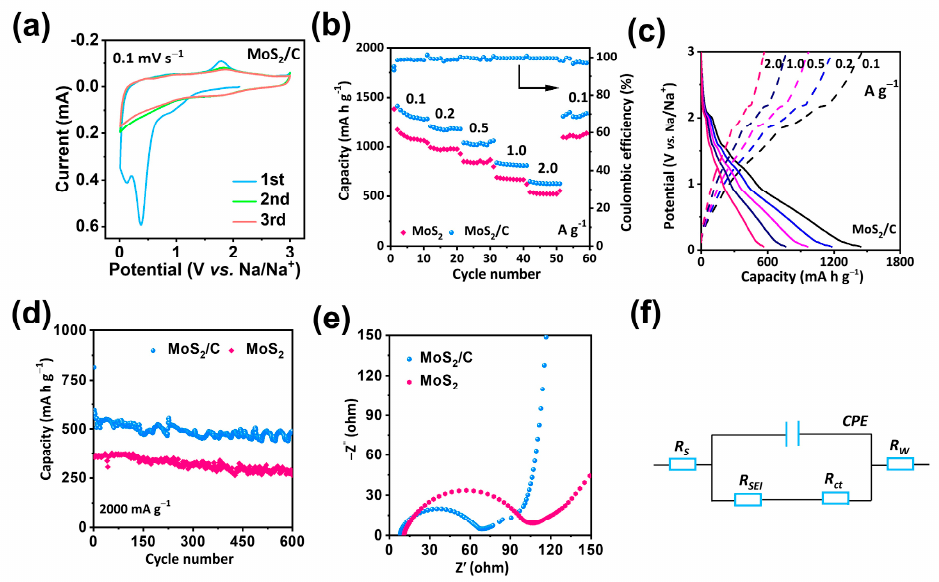
Figure 4. Sodium-ion storage performance. ( a ) CV curves of MoS 2 /C at scan rate of 0.1 mV s − 1 . ( b ) Rate performances at various current densities. ( c ) The GCD curves of MoS 2 /C at various current densities. ( d ) Long-term cycling stability at 2.0 A g − 1 . ( e ) EIS curves of MoS 2 /C and MoS 2 . ( f ) Equivalent circuit model corresponding to the Nyquist plots of the MoS 2 /C.